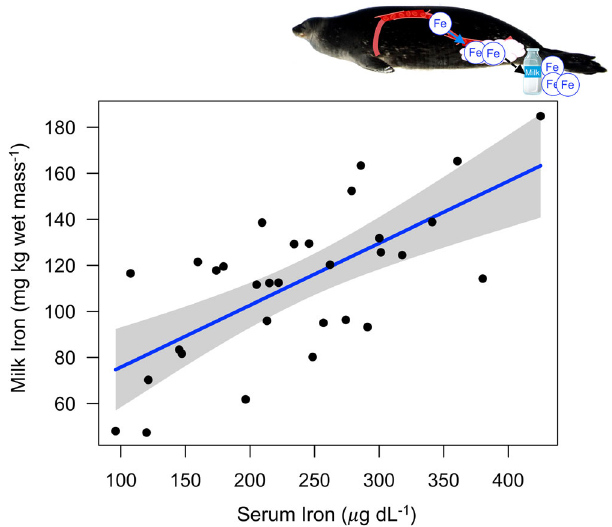
Fig. 2 Females with higher serum iron concentrations incorporated more iron into their milk. Linear regression demonstrating that female Weddell seals with greater circulating serum iron levels incorporated more iron into their milk. Gray bands depict the 95% con fi dence interval around the regression model line (center of error bands). The same relationship was also observed with transferrin-saturation. n = 31. Photo credit: Michelle